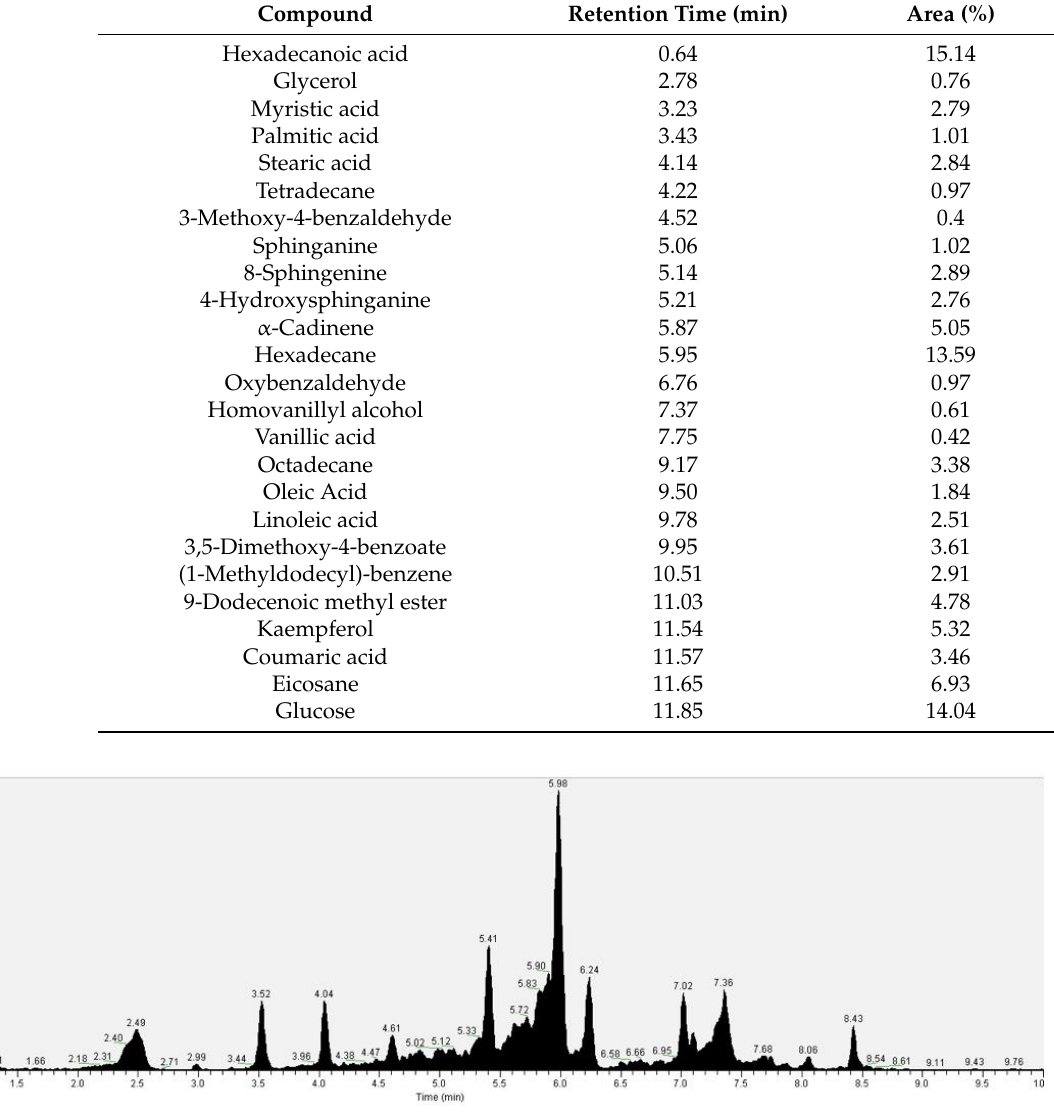
Table 1. GC-MS/MS analysis of Coriolus versicolor.